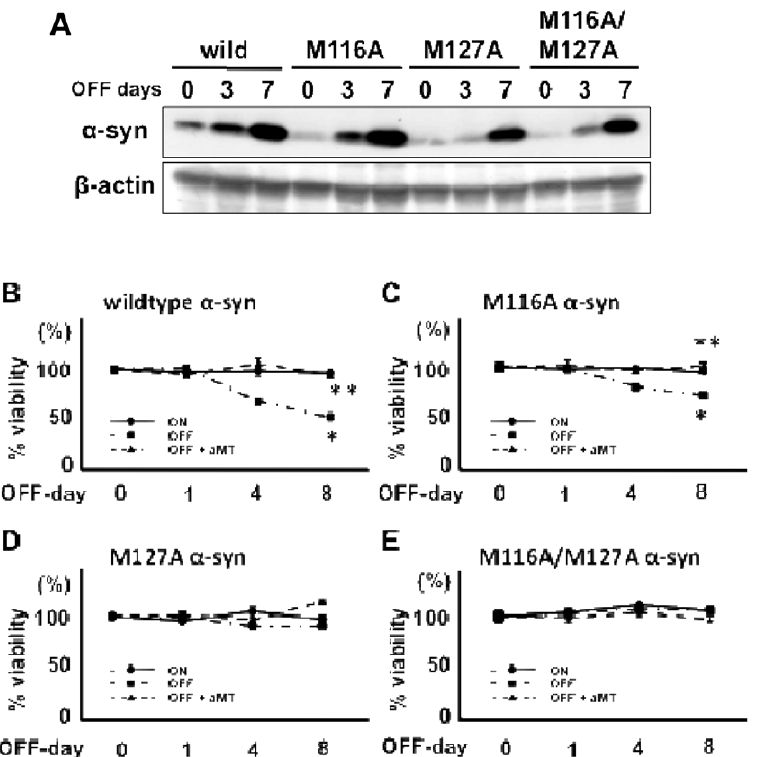
Figure 4. Catecholamine-associated cytotoxicity of a -syn and methionine mutant a -syn in PC12 cells. (A) Western blotting of wildtype (wild), and mutant (M116A, M127A, and M116A/M127A) a -syn expression in Tet-Off- a -syn cells. Withdrawal of Dox from the medium induced a -syn expression 3–7 days after Dox withdrawal. b -actin expression was used as an internal control. (B–E) Cell viability using the MTT assay (B: wildtype a - syn, C: M116A a -syn, D: M127A a -syn, E: M116A/M127A a -syn). (B) The expression of wildtype a -syn following withdrawal of Dox (OFF) reduced cell viability compared to the a -syn-suppressed condition (ON), while inhibition of catecholamine metabolism by aMT (100 m M) dramatically blocked this cytotoxicity. *p , 0.01 vs. ON, **p , 0.01 vs. OFF. (C) The expression of M116A a -syn following withdrawal of Dox (OFF) also reduced cell viability compared to the a -syn-suppressed condition (ON), but to a lesser degree than wildtype a -syn, and aMT (100 m M) blocked this cytotoxicity. *p , 0.01 vs. ON, **p , 0.01 vs. OFF). (D,E) By contrast, expression of the M127A mutant (D) or the combined M116A/M127A (E) mutant a -syn did not reduce cell viability compared to the respective a -syn-suppressed condition (ON), and aMT (100 m M) also had no effect on either.